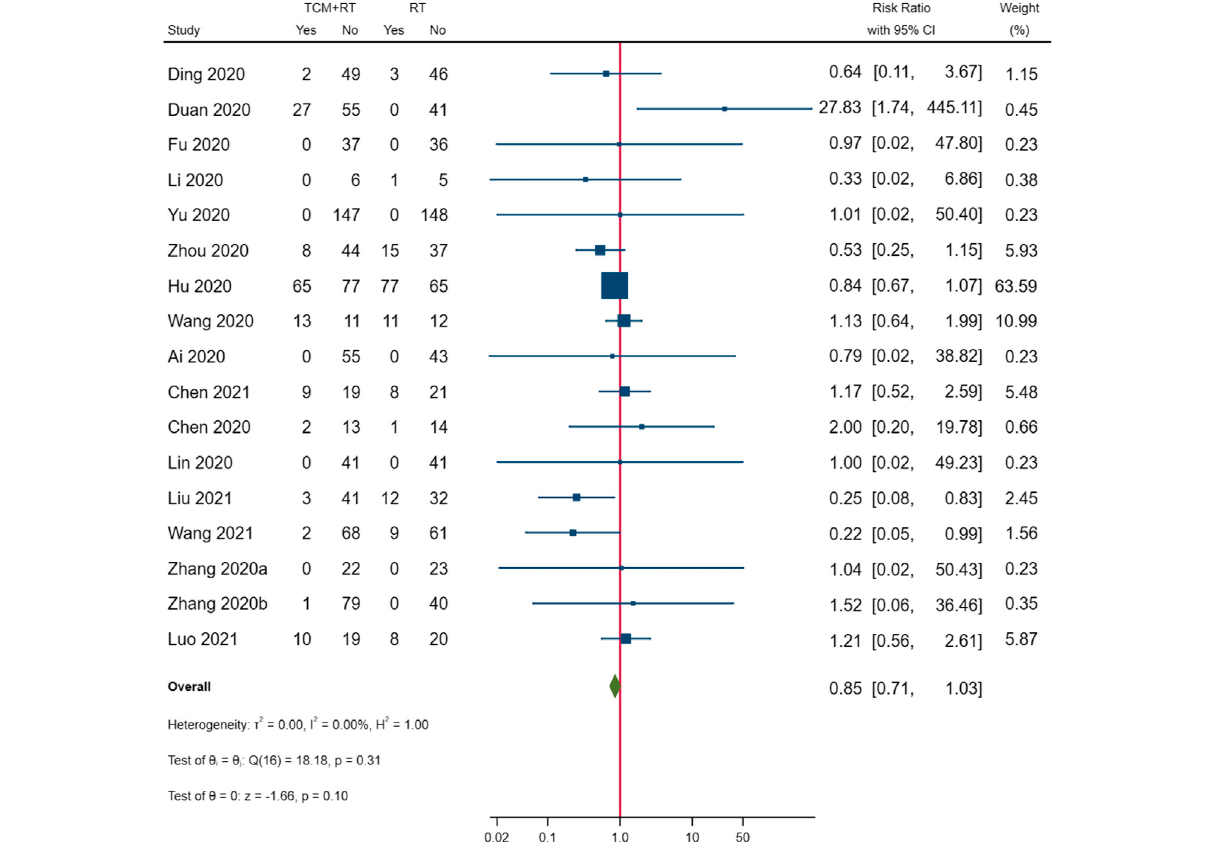
CoV-2 nucleic acid test compared to routine treatment alone ( Figure 4 ; Table 4 ), and no signi fi cant differences were observed in the overall incidence of AEs between TCM plus routine treatment group and routine treatment group ( Figure 10 ).